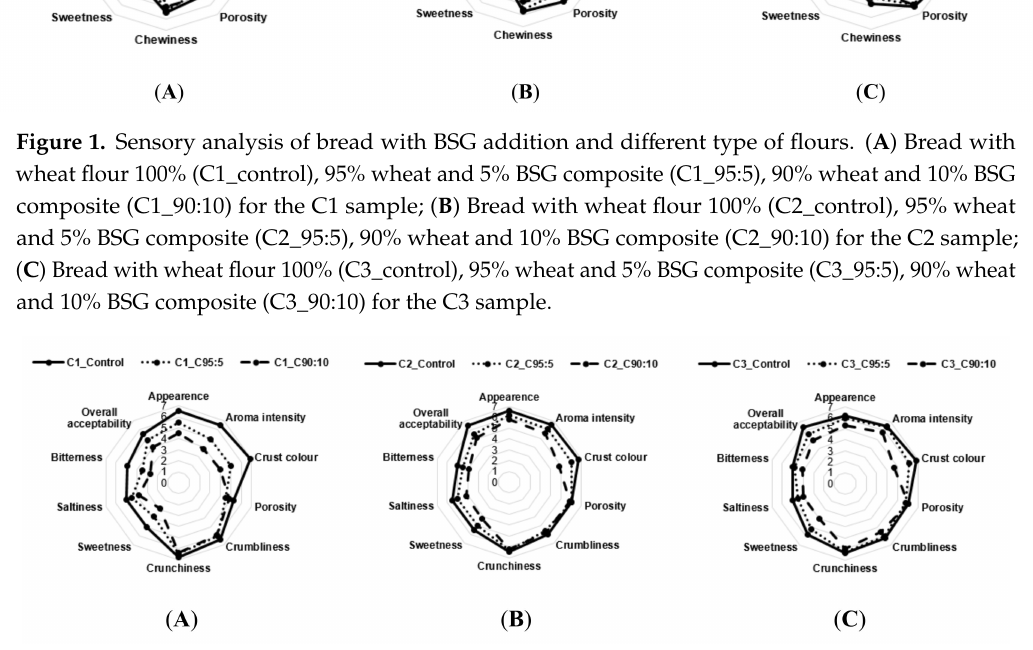
Figure 2. Sensory analysis of breadsticks with BSG addition and di ff erent type of flours. ( A ) Breadsticks with wheat flour 100% (C1_control), 95% wheat and 5% BSG composite (C1_95:5), 90% wheat and 10% BSG composite (C1_90:10) for the C1 sample; ( B ) Breadsticks with wheat flour 100% (C2_control), 95% wheat and 5% BSG composite (C2_95:5), 90% wheat and 10% BSG composite (C2_90:10) for the C2 sample; ( C ) Breadsticks with wheat flour 100% (C3_control), 95% wheat and 5% BSG composite (C3_95:5), 90% wheat and 10% BSG composite (C3_90:10) for the C3 sample.